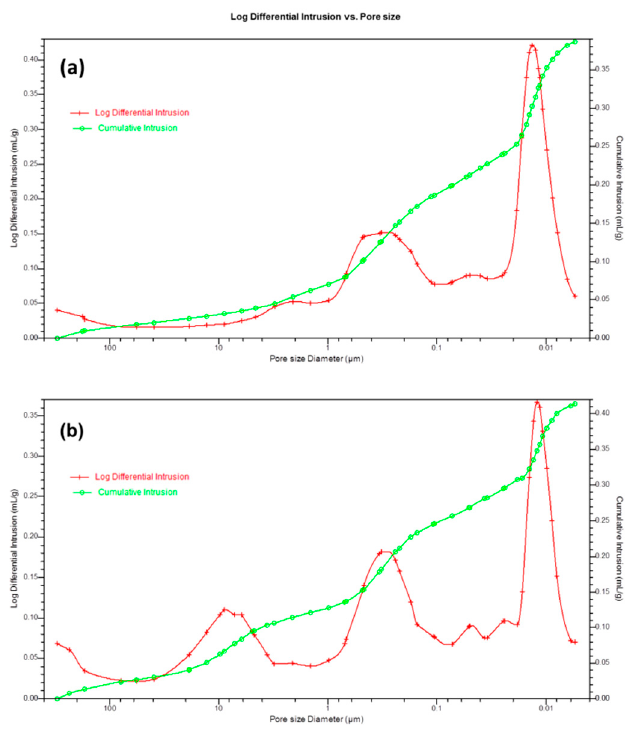
Figure 5. Pore size distribution of biomicroconcretes of materials from Series A ( a ) and Series B ( b ).